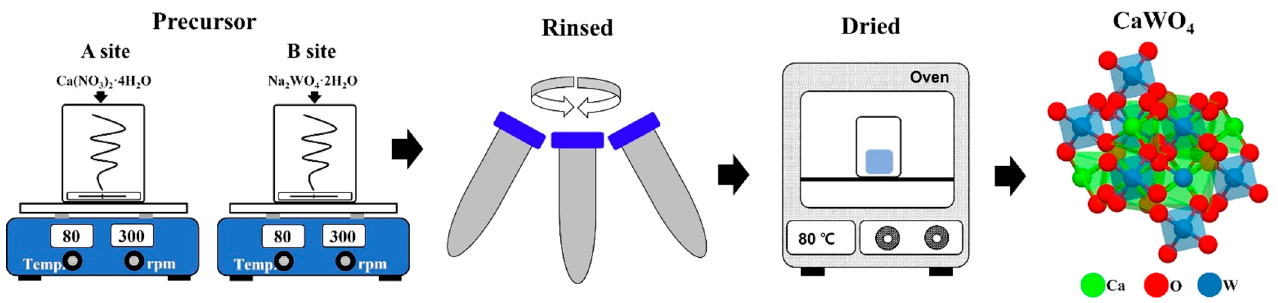
Figure 1. Schematic of the CaWO 4 synthesis procedure.